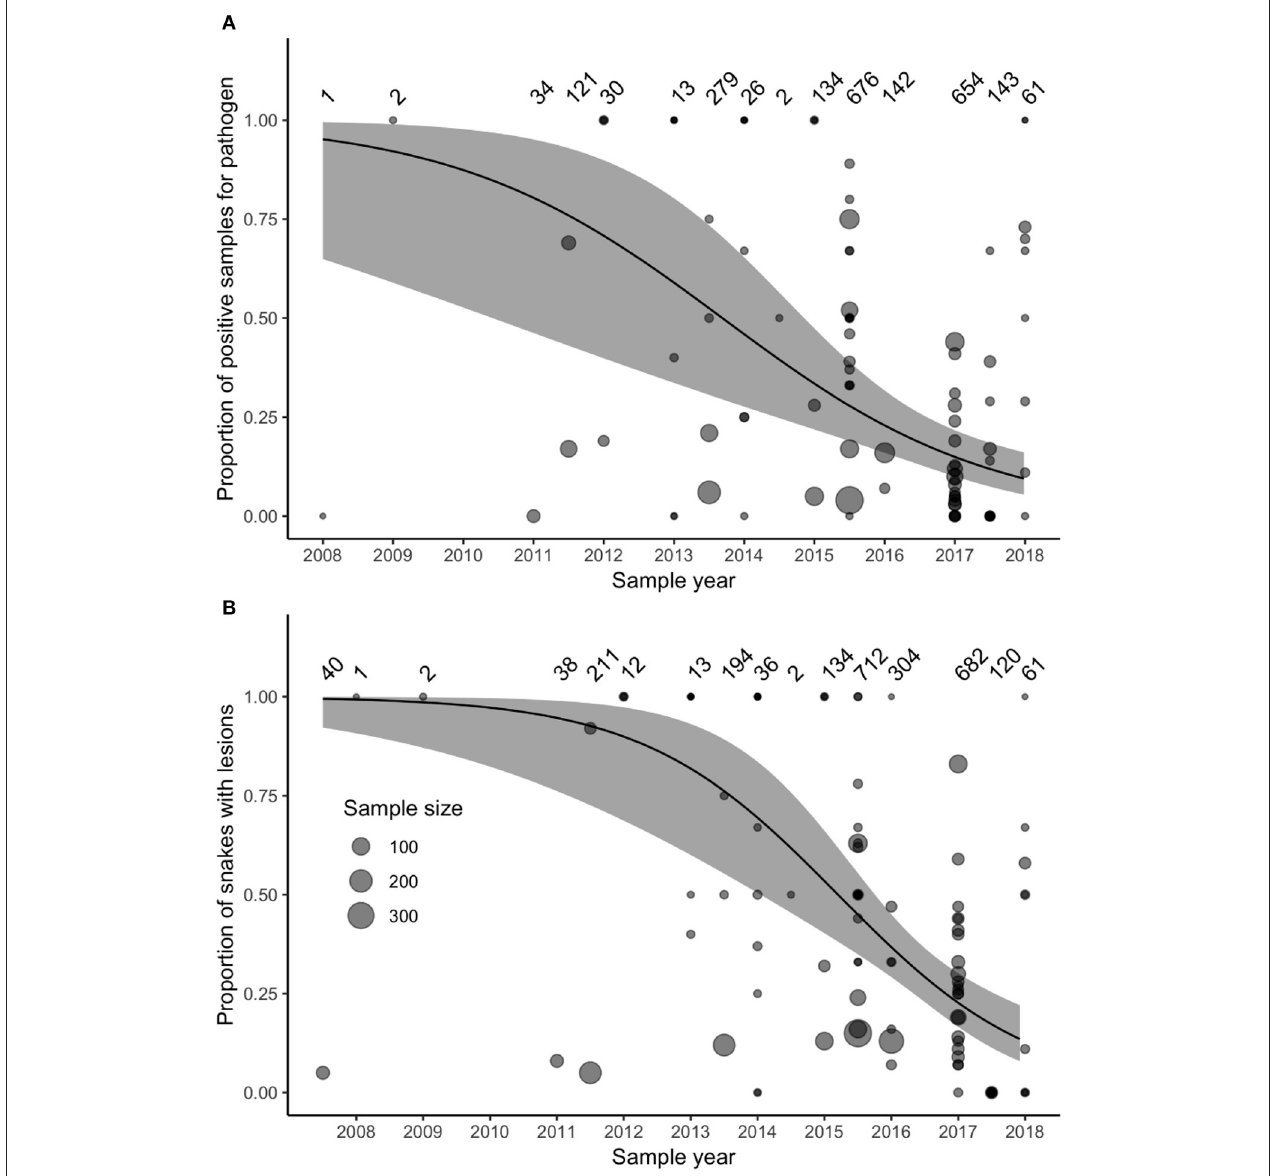
FIGURE 3 | (A) The prevalence of Ophidiomyces ophidiicola (detected through PCR, qPCR, or culture) in samples collected between 2008 and 2018 and reported in the peer-reviewed literature did not increase over time. (B) The prevalence of reported observations of gross lesions suggestive of ophidiomycosis did not increase between 2007 and 2018. Data represent samples collected from 42 species ( Supplementary Table 1 ). Size of points varies with sample size reported in each study, sample sizes for each time-point are noted the top of each panel, and the solid lines and gray-shaded areas indicate the fixed-effect model predictions and 95% confidence